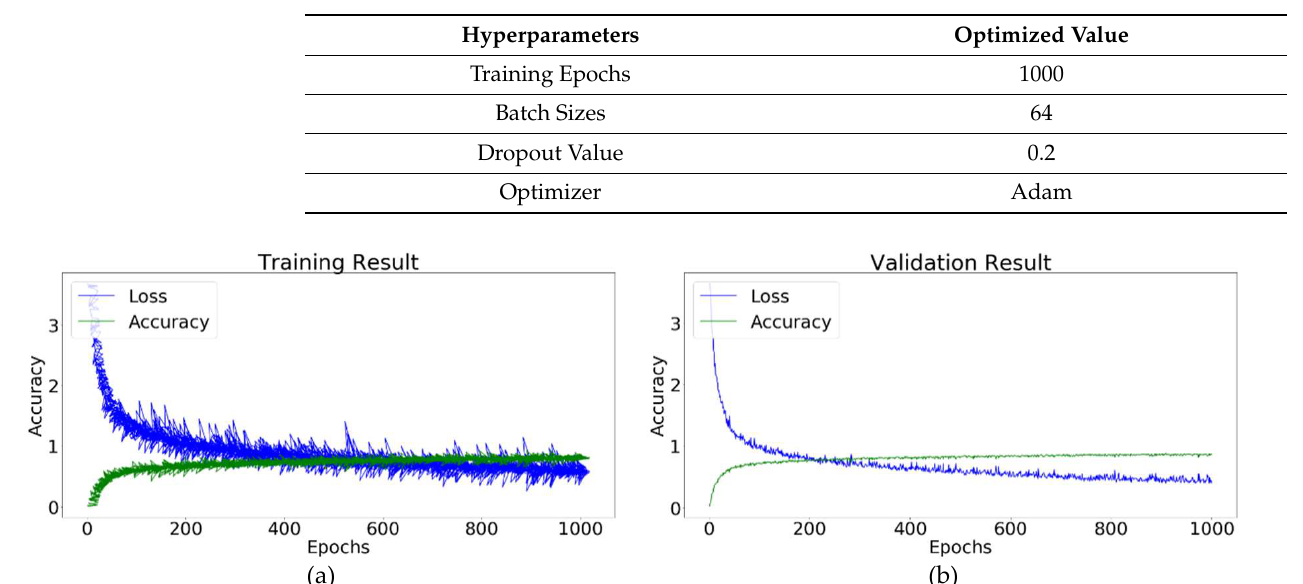
Figure 11. Conv-3 DCNN model: ( a ) Training result; ( b ) validation result.